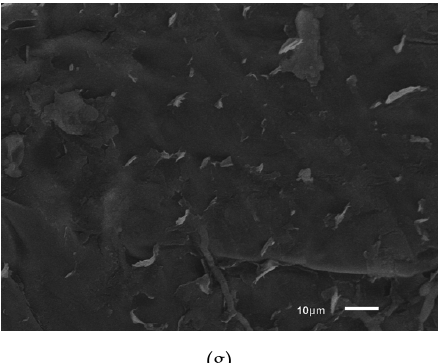
Figure 4. Photomicrographs of strawberry sections intentionally contaminated with ATCC 11229 E. coli cells using different sanitation procedures for 5 min and observed by scanning electron microscopy (3000 × ). ( a ) No treatment; ( b ) Sodium hypochlorite 1 mL/L; ( c ) Ultrasound 40 kHz; ( d ) Acetic acid 10 mL/L; ( e ) Acetic acid 10 mL/L and Ultrasound 40 kHz; ( f ) Peracetic acid 2 mL/L; ( g ) 2 mL/L peracetic acid and 40 kHz ultrasound.